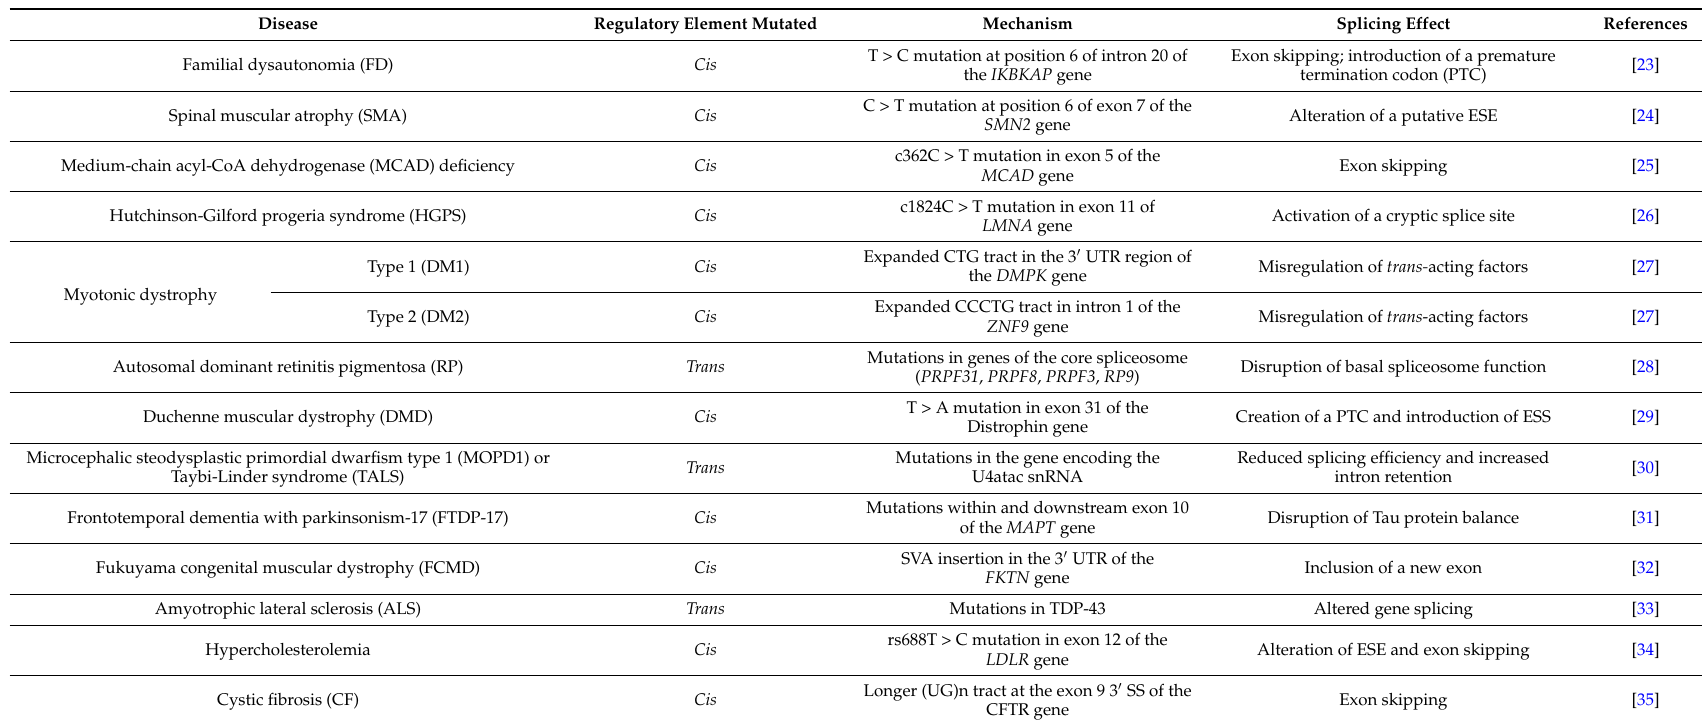
Table 1. Summary of splicing-related diseases that might be target for gene